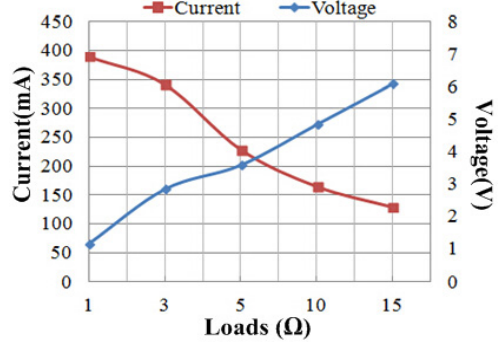
Figure 14. Channel 1 is output voltage, Channel 2 is output current, and Channel 3 is constant output voltage of buck converter for supercapacitor is 5.0 V.